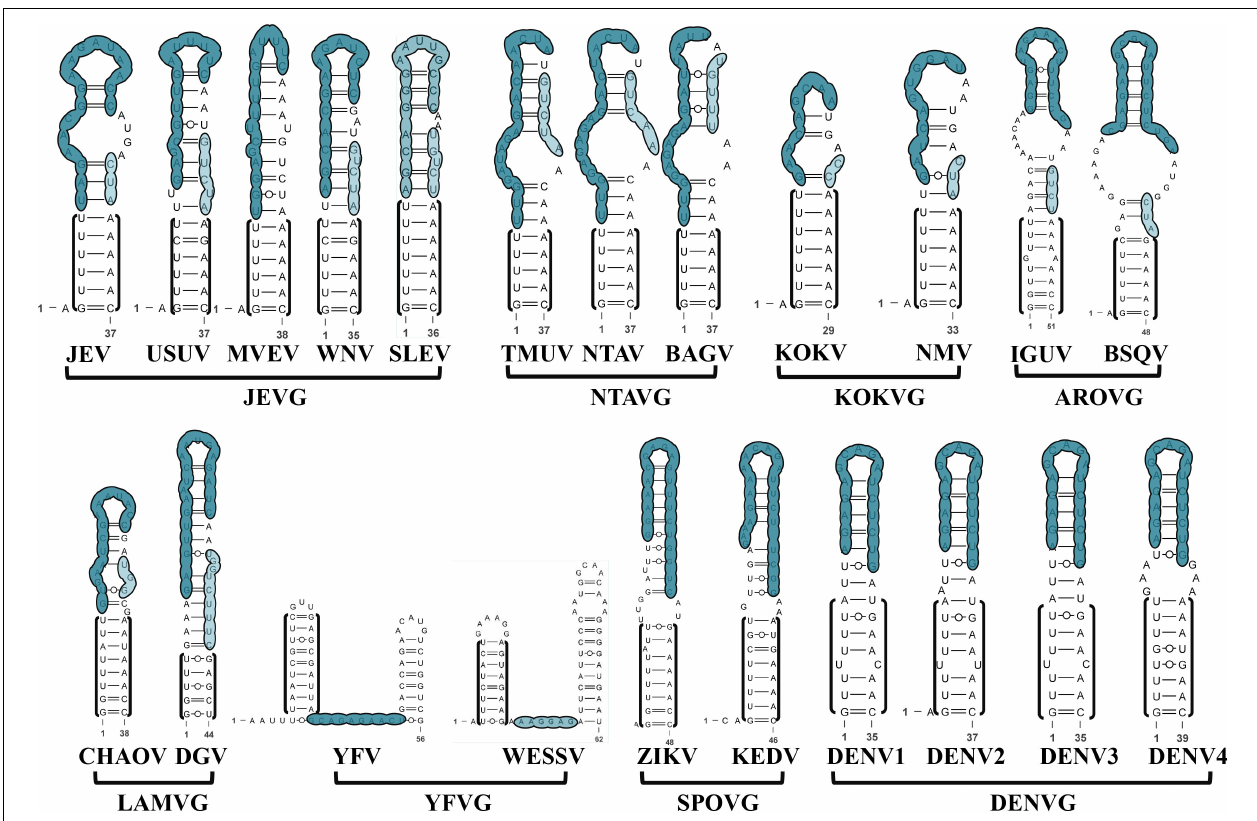
FIGURE 4 | The secondary structure of 5 (cid:48) SLB from eight MBFVGs is group-specific. The 5 (cid:48) UFS base-pairing is indicated at the bottom of 5 (cid:48) SLB in the black bracket. The nucleotides that participate in the MBFV 5 (cid:48) UAR and 5 (cid:48) DAR are labeled in respective colors as above.